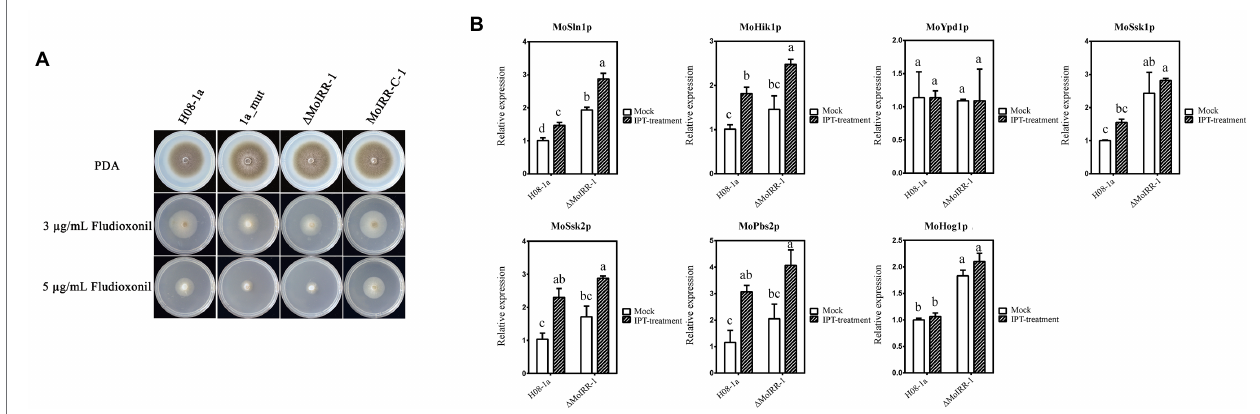
FIGURE 5 | MoIRR-deficient strains showed increased susceptibility to FLU. (A) Growth inhibition of the resistant mutant 1a_mut, MoIRR knockout transformant Δ MoIRR-1, and MoIRR-complemented transformant MoIRR-C-1 compared to the wild-type isolate H08-1a on FLU-containing PDA. Growth of 1a_mut and Δ MoIRR-1 were inhibited more than H08-1a at both concentrations of 5 and 3 μ g/ml FLU. But the growth of MoIRR-C-1 was similar to H08-1a. Mycelial plugs were taken from the edge of a 5 dpi colony of isolates or mutants and grown at 27 ° C for 6 days on PDA plates with FLU at a concentration of 0, 3, or 5 μ g/ml. (B) The expression level of seven genes in Hog1 MAPK pathway was assessed using qRT-PCR in the Δ MoIRR-1 and H08-1a. MoSln1, MoSsk1, and MoHog1 were expressed higher in the Δ MoIRR-1 than in H08-1a. And expressions of MoSln1, MoHik1, MoSsk2, and MoPbs2 were induced under IPT treatment. RNAs extraction was the same with Figure 4 . Different letters were calculated based on the replicates of treatments with Duncan test analysis indicate statistically significant differences ( p = 0.05).